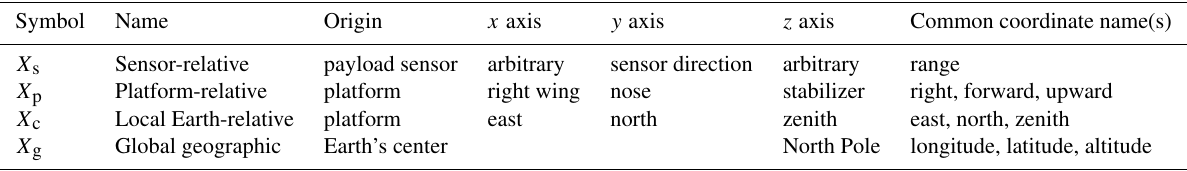
Table 4. Positions and orientations of the reference frames. The x and y axes of X g are defined in the common way: x g points towards the intersection of the Equator and the prime meridian and the y g in the direction that completes the right-handed perpendicular coordinate system. Note that X c is not located on the planet’s surface but on the